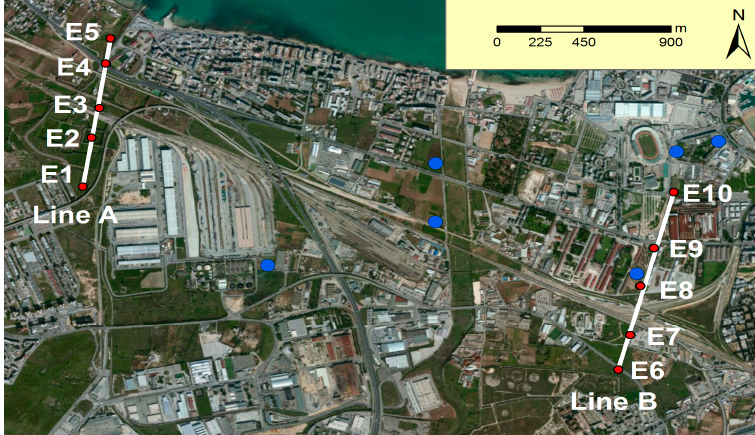
Figure 3. ERT profile locations. Blue points are boreholes (six) used for salinity measurements to calibrate Equation (7) by using resistivity data provided by ERT profiles. Table 2. Transmission (i.e., operating) parameters used in ERT surveys. Table 2. Transmission (i.e., operating) parameters used in ERT